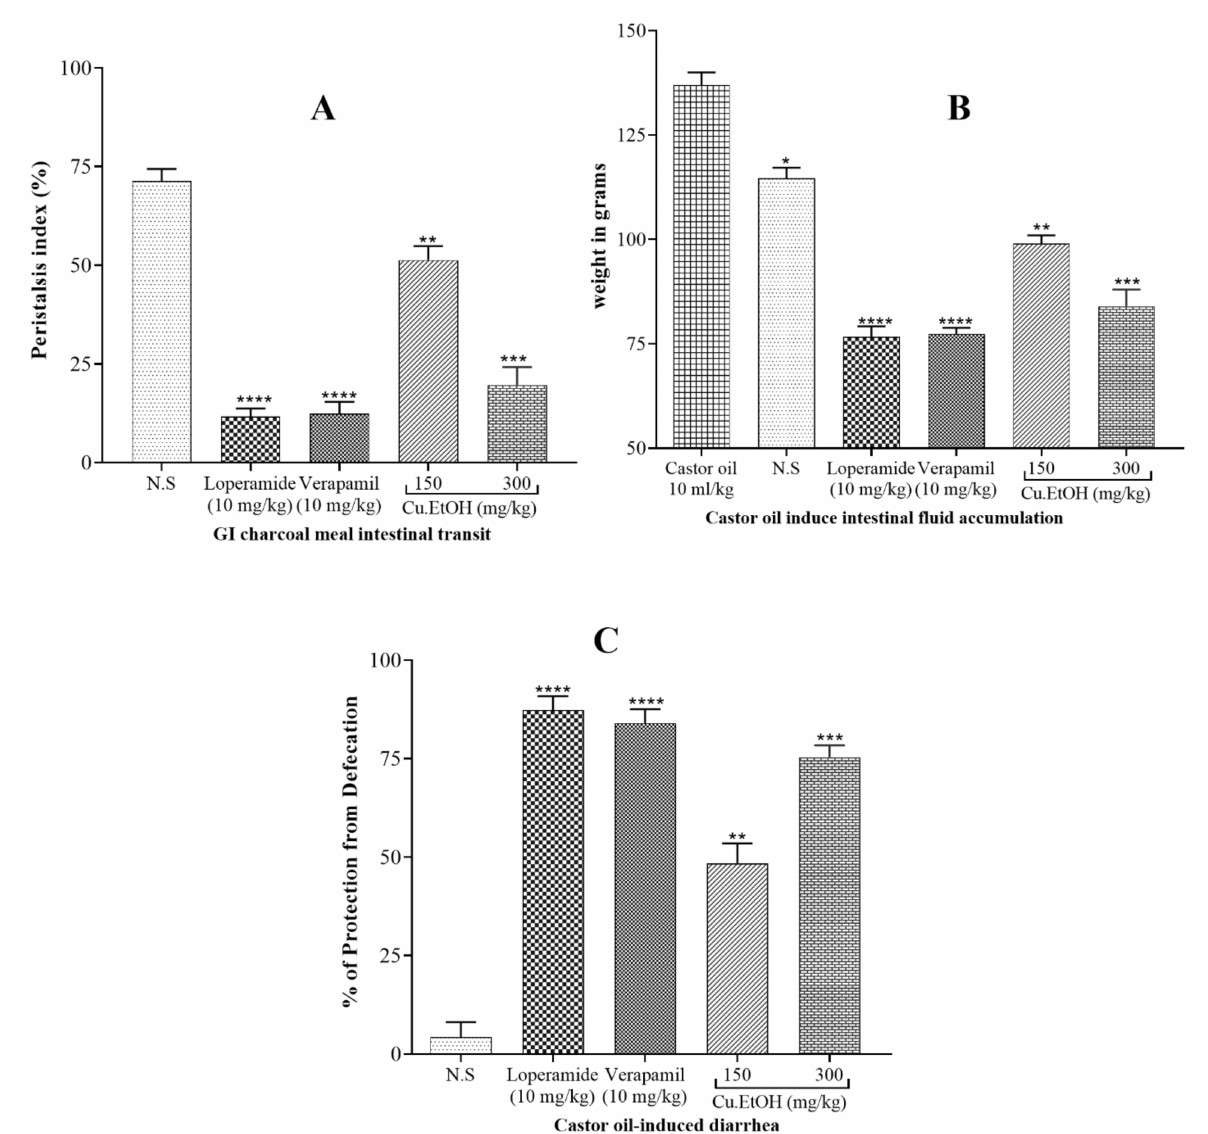
Figure 11. In vivo studies; ( A ) antiperistalsis; ( B ) castor oil induces fluid accumulation inhibition; and ( C ) antidiarrheal effect of seeds extract and verapamil. (Values are expressed as Mean ± SD, data was analyzed by one-way ANOVA followed by Dunnett’s test for in vivo compared to control (normal saline or castor oil group) and p < 0.05 was considered significant (* p < 0.05, ** p > 0.01, *** p < 0.001, **** p < 0.0001), N.S: Normal Saline (10